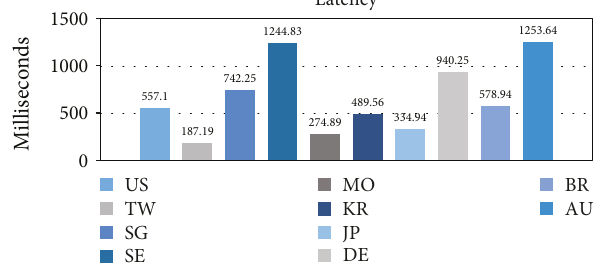
Figure 8: Geographical measurements of the emulation mode with hop (latency).